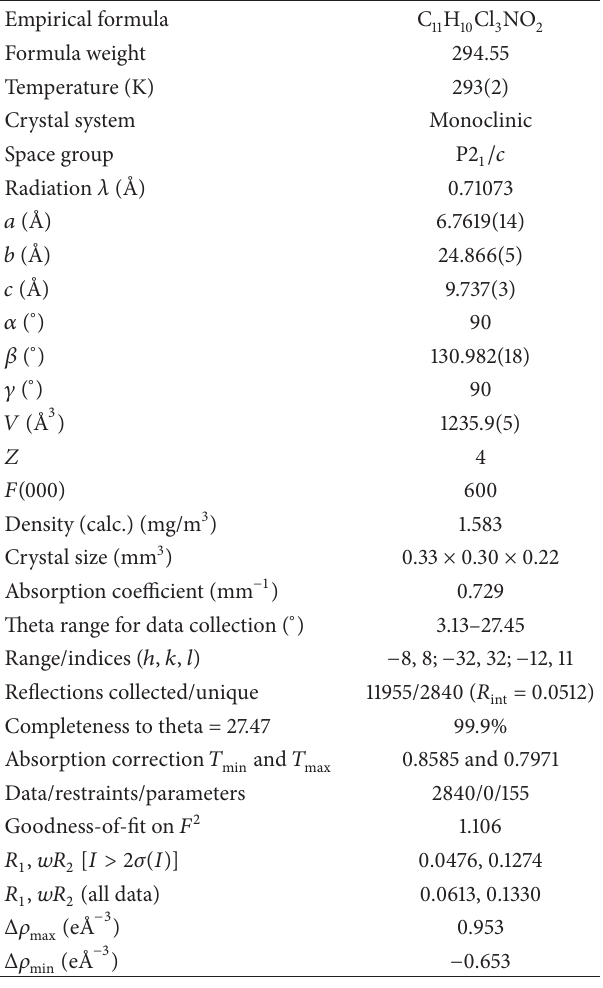
Table 1: Crystal and structure refinement for the title